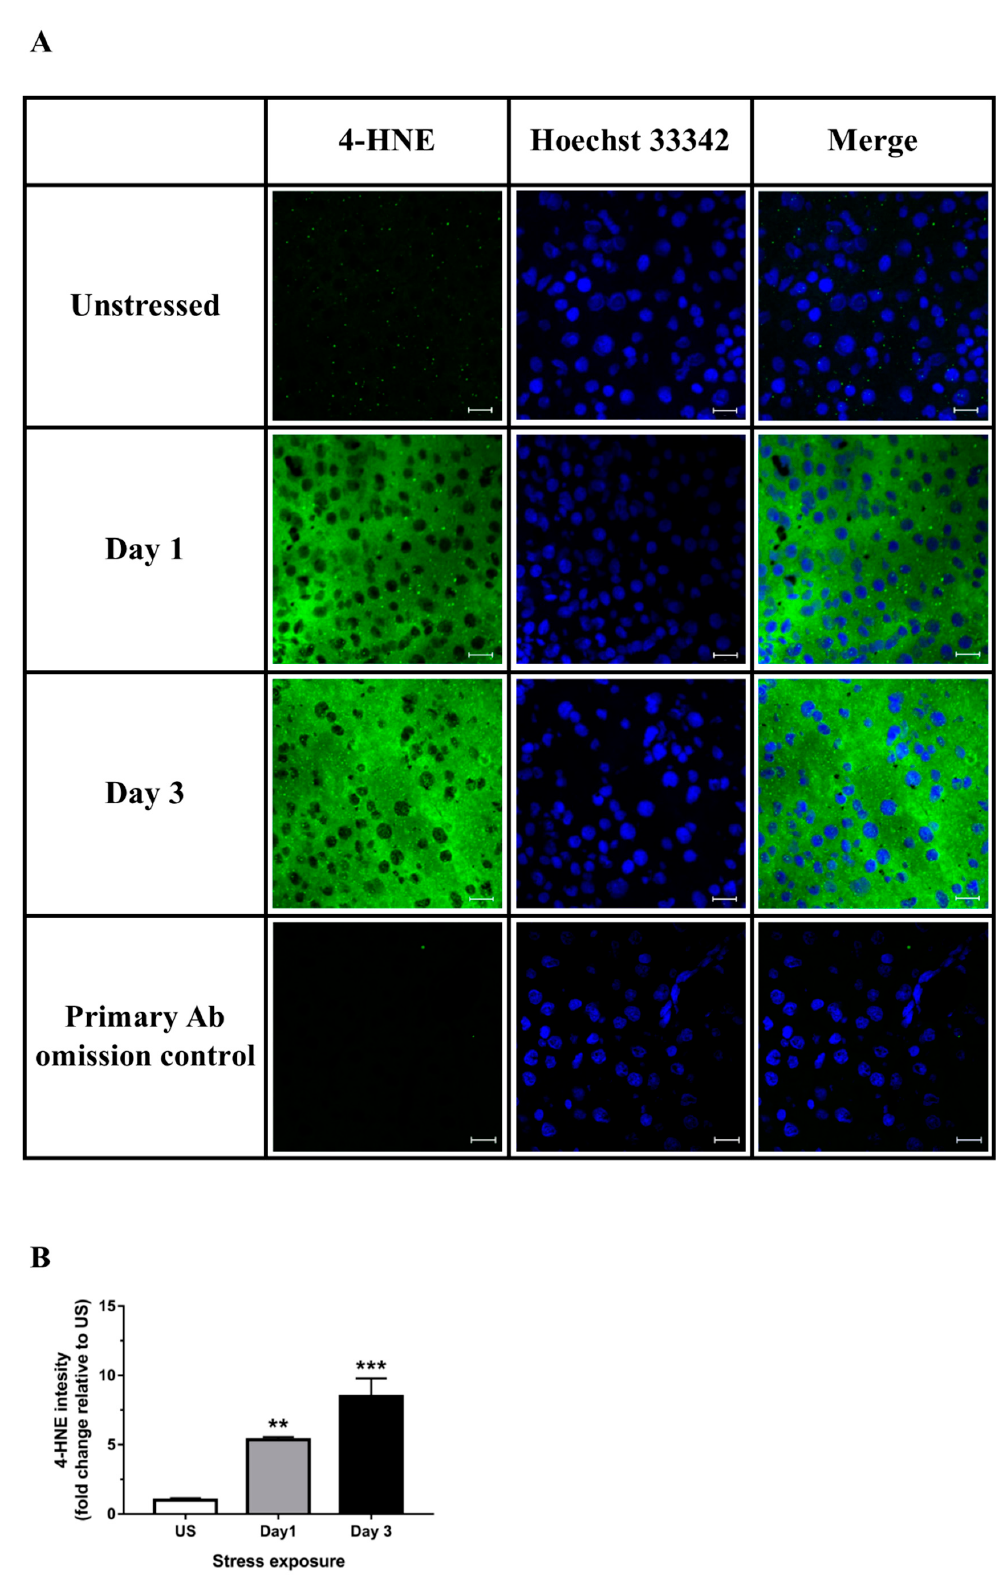
Figure 5. Representative images of ( A ) hepatic 4-hydroxynonenal (4-HNE; scale bar = 20 µm) and ( B ) corresponding image quantification (n = 3). Results in ( B ) were analyzed using one-way ANOVA with Fisher’s LSD test. Data are expressed as mean ± SEM, ** p < 0.01, *** p < 0.001.